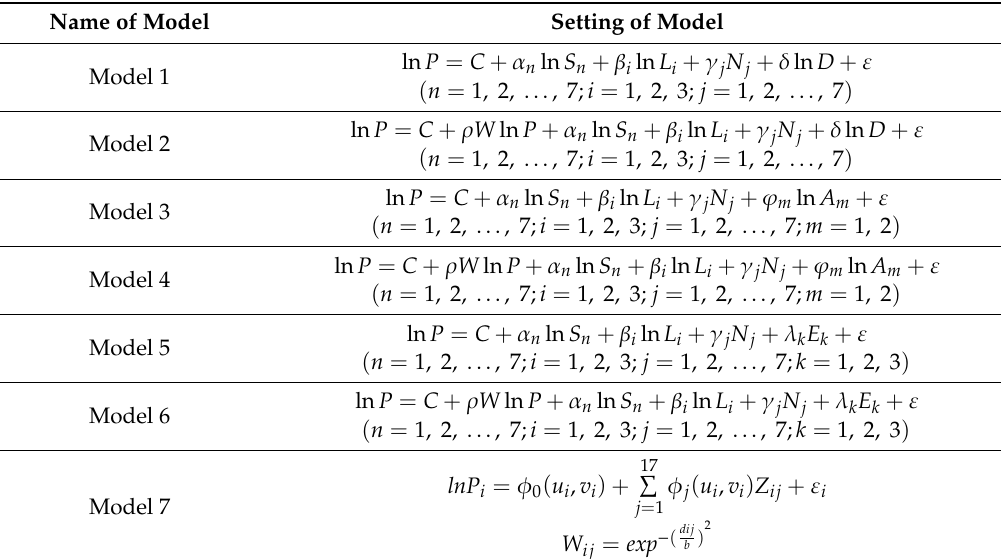
Table 3. The summary of model